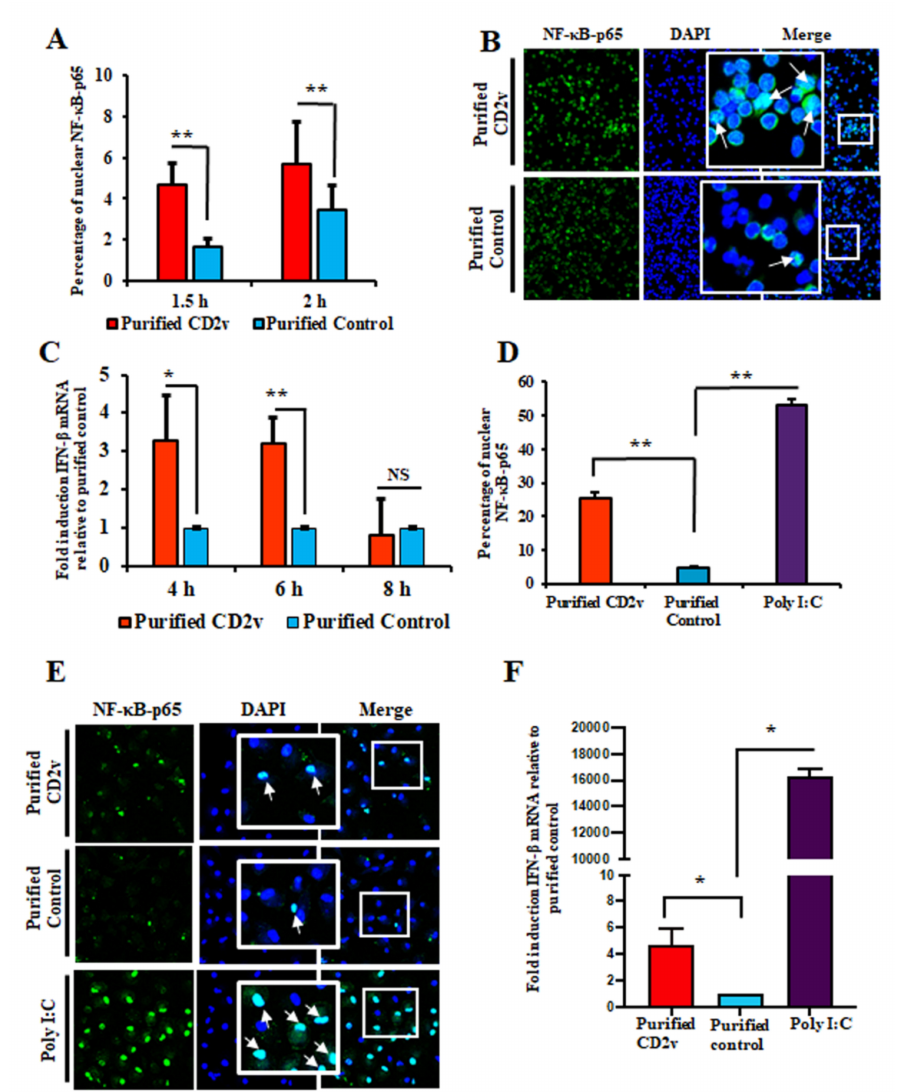
Figure 6. Purified CD2v protein induces NF-kB-p65 nuclear translocation and IFN- β transcription in swine PBMCs and macrophages. ( A ) NF-kB-p65 nuclear translocation in swine PBMCs. Swine PBMCs were treated with purified CD2v or purified control, fixed at 1.5 h and 2 h post treatment and assessed for NF- κ B-p65 nuclear translocation by immunofluorescence as described in Materials and Methods. Approximately 2000 cells were counted/slide and results are shown as mean values from four independent experiments (1.5 h, p = 0.01; 2 h, p = 0.01). ( B ) Representative confocal images of NF- κ B-p65 nuclear translocation. Green, NF- κ B-p65; Blue, DAPI. Insets show magnified areas of the field. Arrows indicate nuclear NF- κ B-p65. ( C ) IFN- β transcription. Cells were treated as in A, total RNA harvested at 4 h, 6 h and 8 h post treatment and IFN- β transcription assessed by RT-PCR. Fold changes are relative to purified control and data are the mean mRNA levels of seven independent experiments (4 h, p = 0.016; 6 h, p = 0.002). ( D ) NF- κ B-p65 nuclear translocation in macrophages. Primary swine macrophages were treated with purified CD2v or purified control, fixed at 2 h post treatment and assessed for NF- κ B-p65 nuclear translocation as in A. Approximately 300 cells were counted/slide and results are shown as the mean values from three independent experiments (for purified CD2v, p = 0.002). ( E ) Representative images of NF- κ B-p65 nuclear translocation in macrophages. Green, NF- κ B-p65; Blue, DAPI. Insets show magnified areas of the field. Arrows indicate nuclear NF- κ B-p65. ( F ) CD2v-mediated induction of IFN- β in swine macrophages. Primary swine macrophages were treated with purified CD2v or purified control, the total RNA was harvested at 6 h post treatment and IFN- β transcription was assessed by RT-PCR. Fold changes are relative to the purified control and data are the mean mRNA levels of three independent experiments (for purified CD2v, p = 0.034). (*, p < 0.05 and **, p <